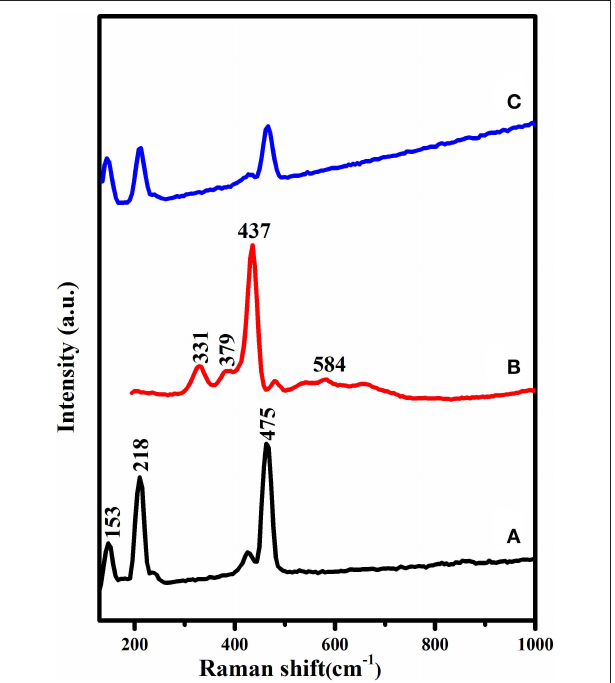
FIGURE 4 | Raman spectra of (A) sulfur, (B) ZnO, and (C) S/PT